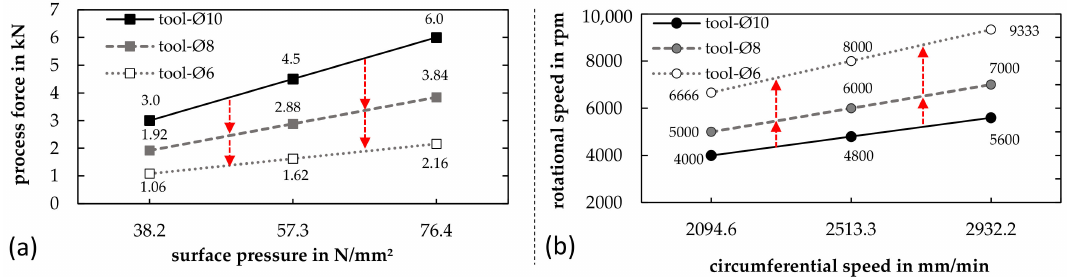
Figure 14. Tool diameter scaling approach—scaling of process forces ( a ) and rotational speed ( b ) with respect of constant surface pressure and circumferential